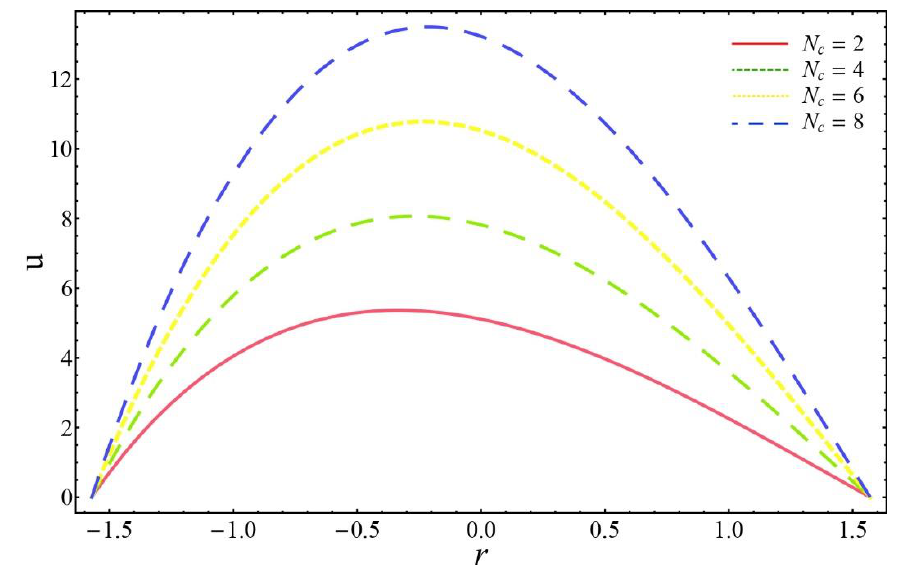
Figure 2. Alteration of 𝑁 𝑐 on u when 𝑥 = 0.2; 𝑡 = 0; 𝑄 = 10; 𝛽 = 0.1; 𝜖 = 0.6; 𝑁 𝑟1 = 2; 𝑘 = 2; 𝐸 1 = 0.1; 𝐸 2 = 0.1; 𝐸 3 = 0.9.